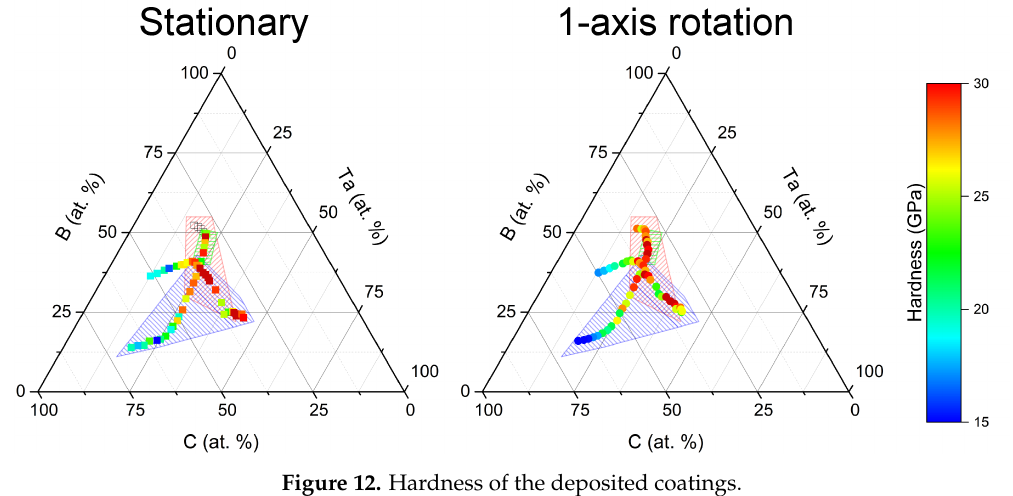
Figure 12. Hardness of the deposited coatings.